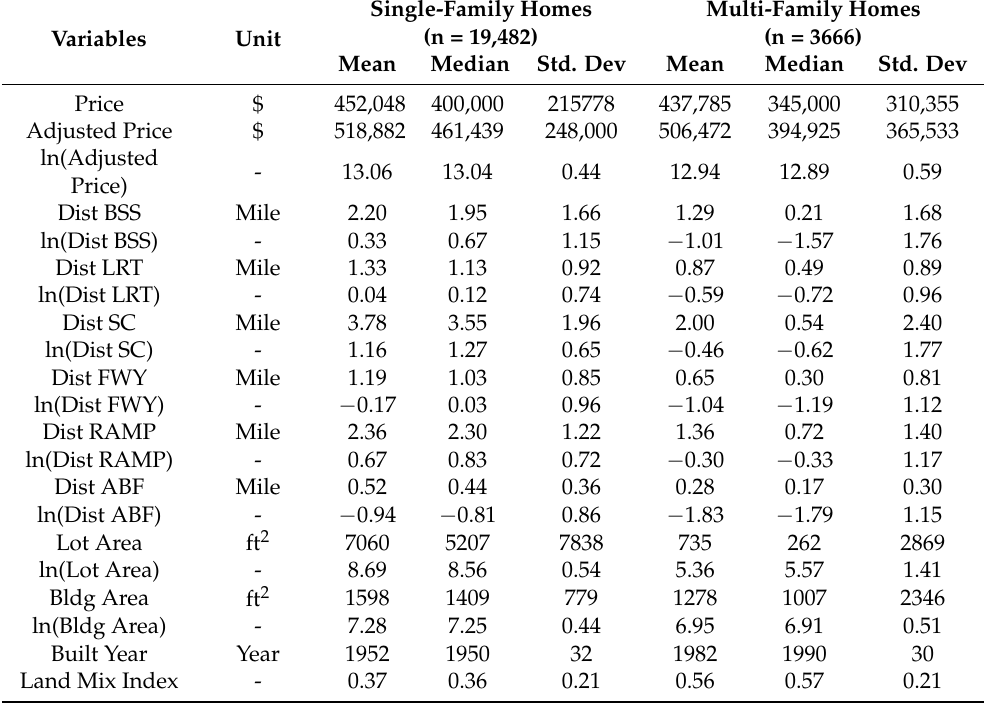
Table 2. Descriptive statistics of